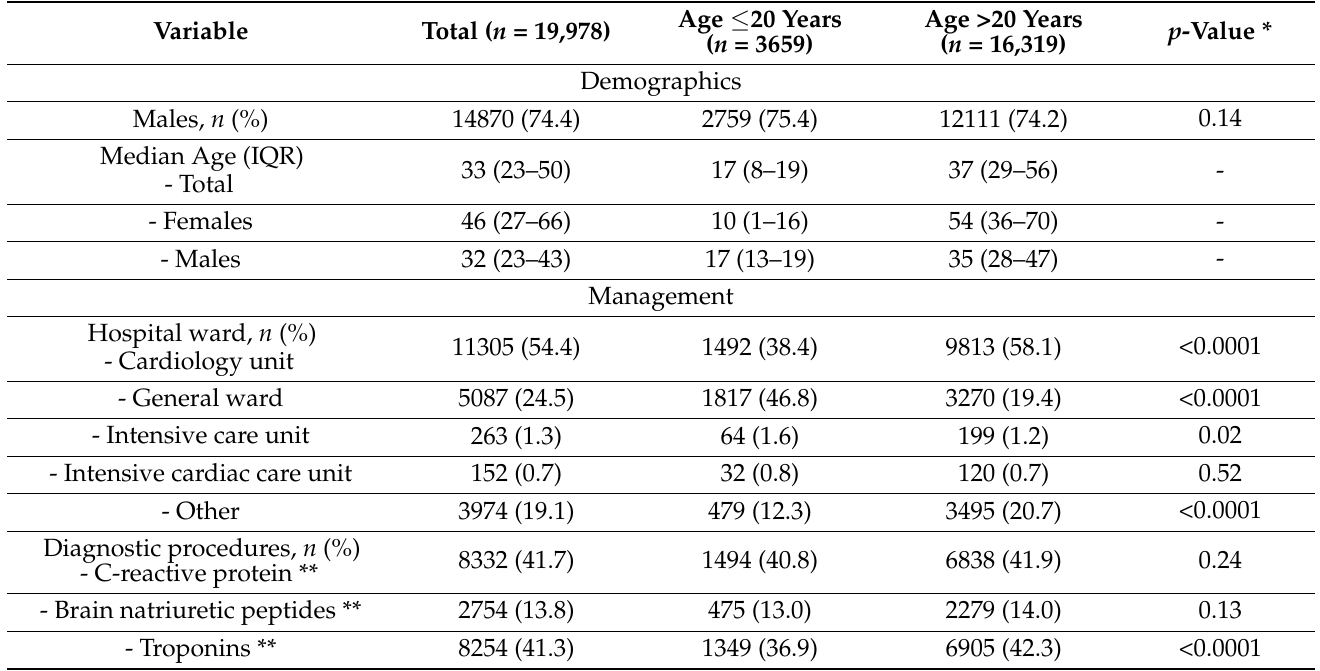
Figure 2. Age-standardized hospitalization rates for myocarditis of males and females by the number of residents in Poland in the years 2011–2019. Table 2. Clinical characteristics and performed diagnostic procedures in hospitalized patients with Most of the clinical characteristics differed between patients aged ≤ 20 and >20 years. Chronic diseases, except for a history of asthma, were more common in the older group. Diagnoses of otolaryngologic and ophthalmic or digestive infectious disease in the prior 6 months were observed more frequently in the younger group. Patients aged ≤ 20 years were